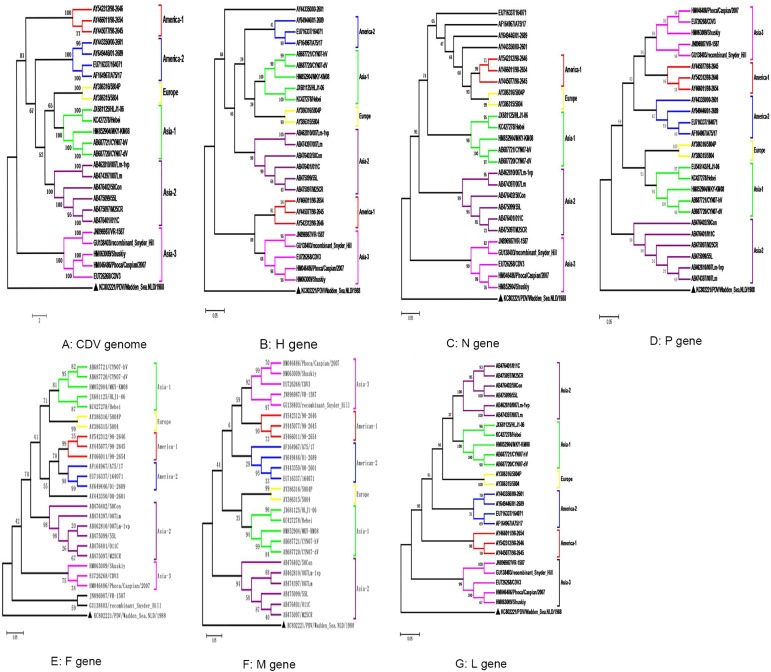
Phylogenetic tree analysis of 25 full-length CDV genomes.The distances were calculated by the ClustalW program with the MEGA 5.0 software package. The ML algorithm was used to generate the tree. Bootstrap values were calculated based on 1000 replicates. The result contains six groups: Asia-1, Asia-2, Asia-3, Europe, America-1, and America-2. Triangle (▲) indicates the out-group strains analyzed in this study.